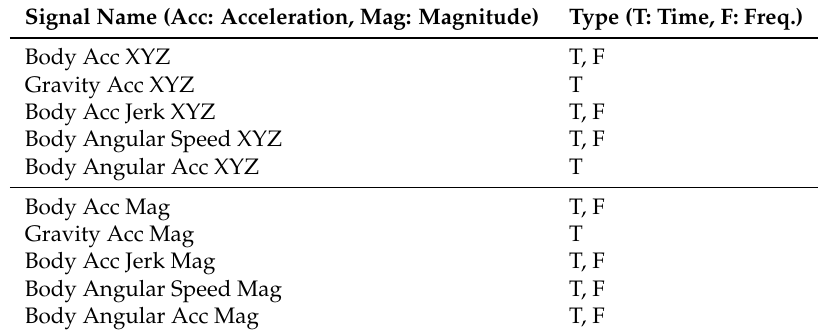
Table 1. Time and frequency domain signals generated from accelerometer and gyroscope.